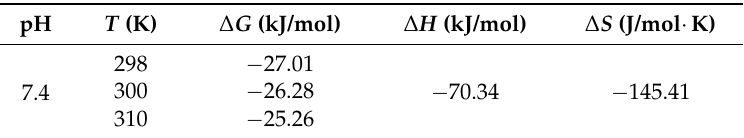
Table 4. Thermodynamic parameters obtained for the Dp44mT-HSA interaction as described